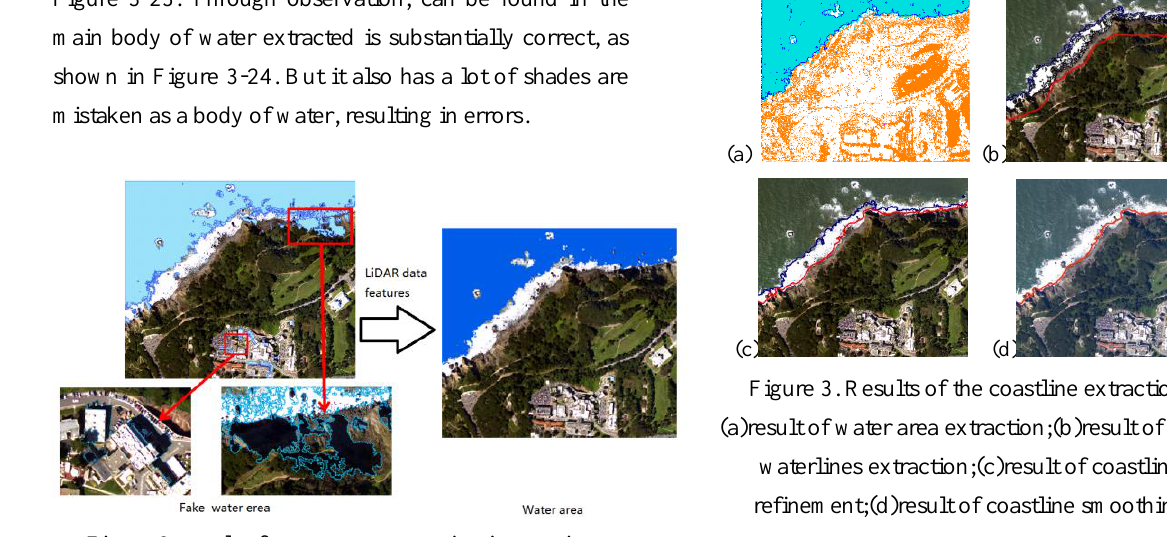
Figure 2. result of water area extraction integrating NDWI and LiDAR data features